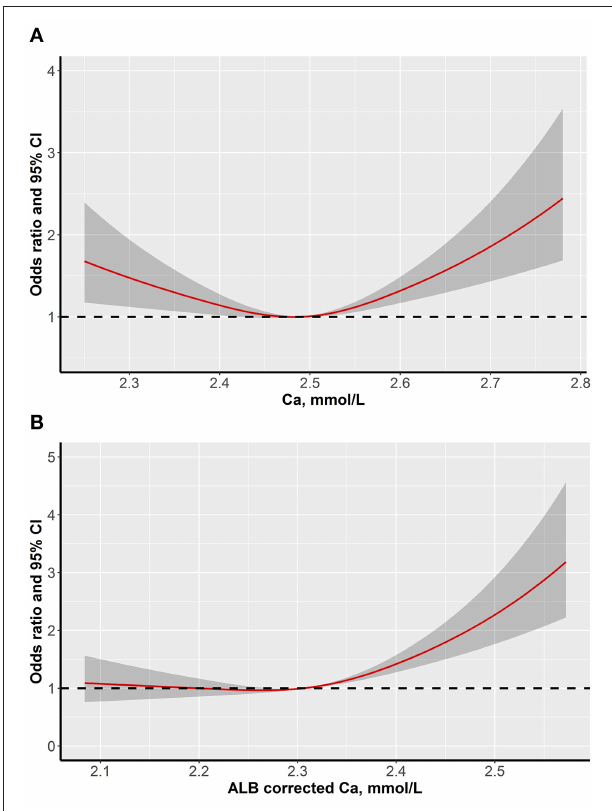
FIGURE 2 | Dose-response associations between serum calcium levels and dyslipidemia ( A is serum calcium levels and B is albumin-corrected calcium